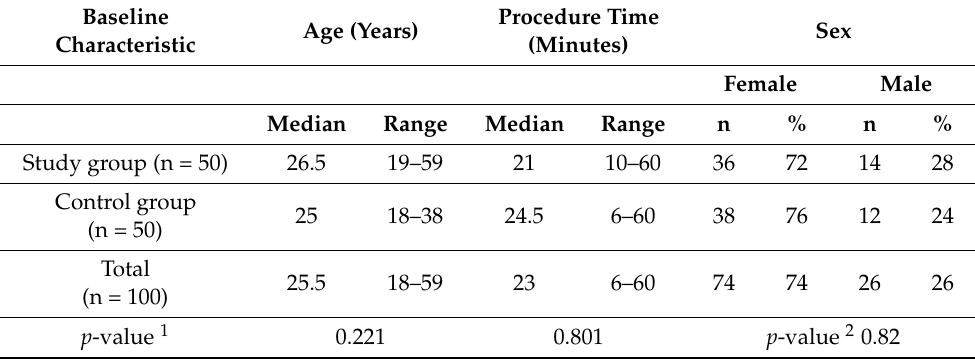
Table 5. Study groups